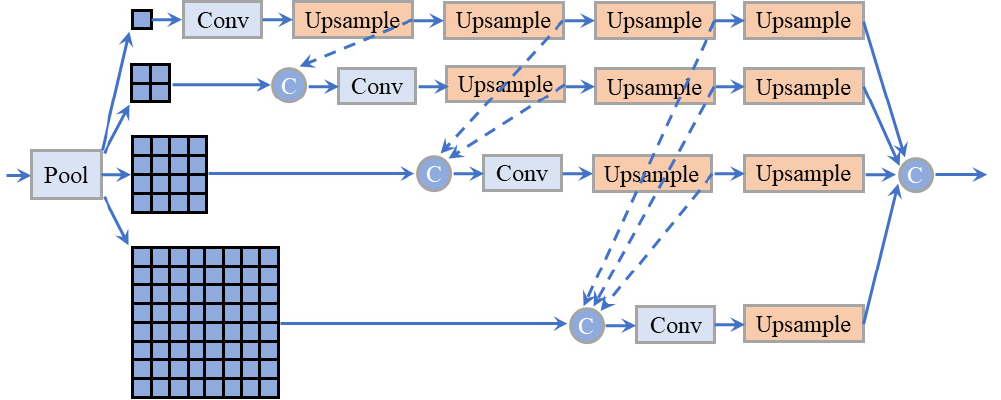
Figure 4. Illustration of the Dense Pyramid Pooling Module.